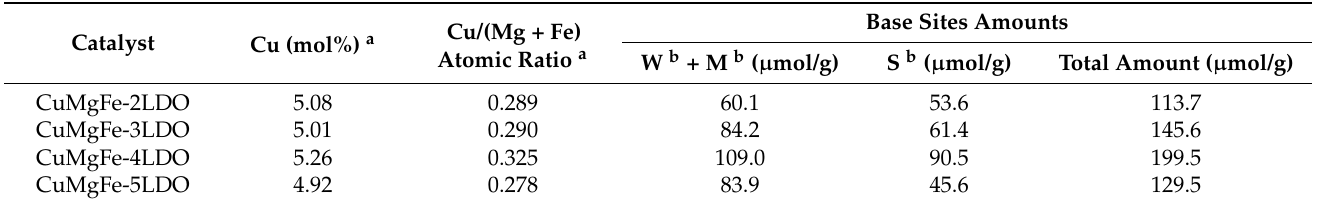
Table 2. The surface element composition and the base sites amounts of CuMgFe-xLDO catalysts. Catalyst